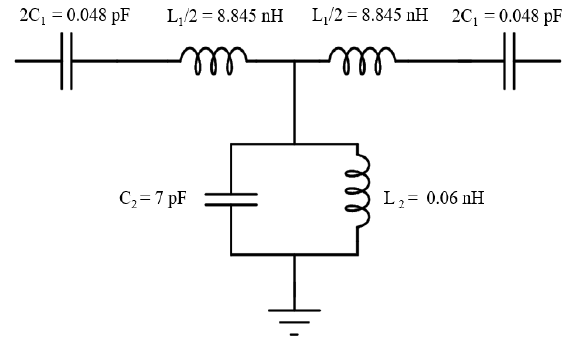
FIGURE.7. EQUIVALENT CIRCUIT OF MOORE FRACTAL APPLIED SYMMETRICAL RING RESONATOR BANDPASS FILTER.